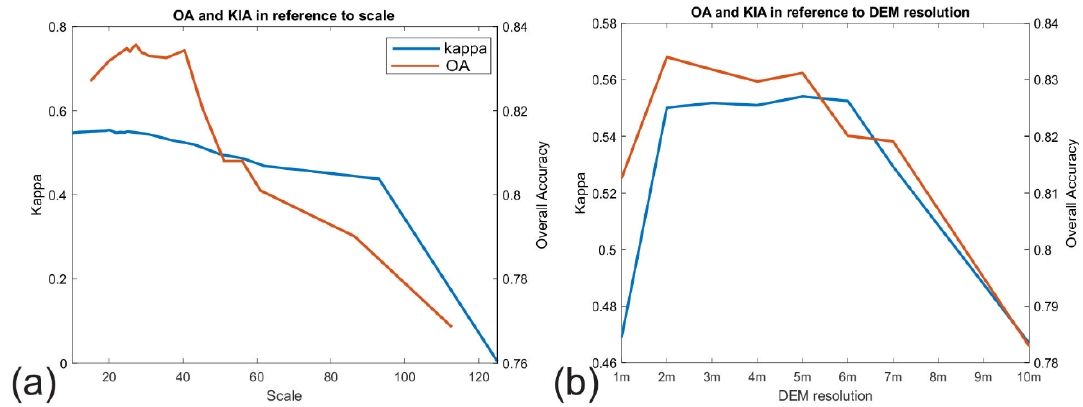
Figure 7. Kappa and accuracy with reference to ( a ) scale and ( b ) DEM resolution used for segmentation in OBIA.